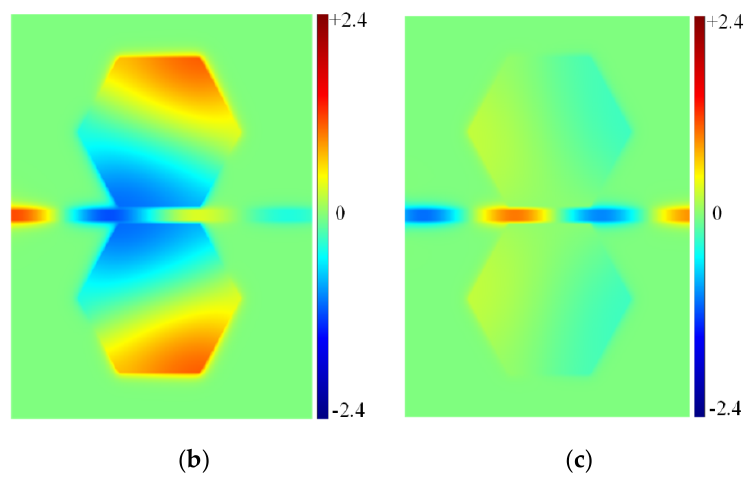
Figure 4. ( a ) Simulated transmission spectrum of the proposed sensing structure. The contour profiles of the field distributions of |Hz| at wavelengths of ( b ) 1548.5 nm and ( c ) 1500 nm, respectively.